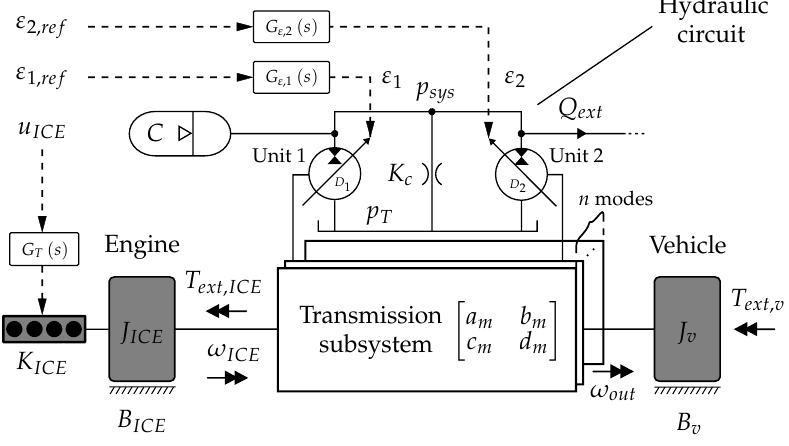
Figure 1. Linear lumped-parameter model of a general complex multi-mode hydraulic hybrid transmission with n modes, in mode m . Q ext and T ext , ICE are disturbances caused by, for instance, work functions, while T ext , v is a disturbance from a load, e.g., a gravel pile.